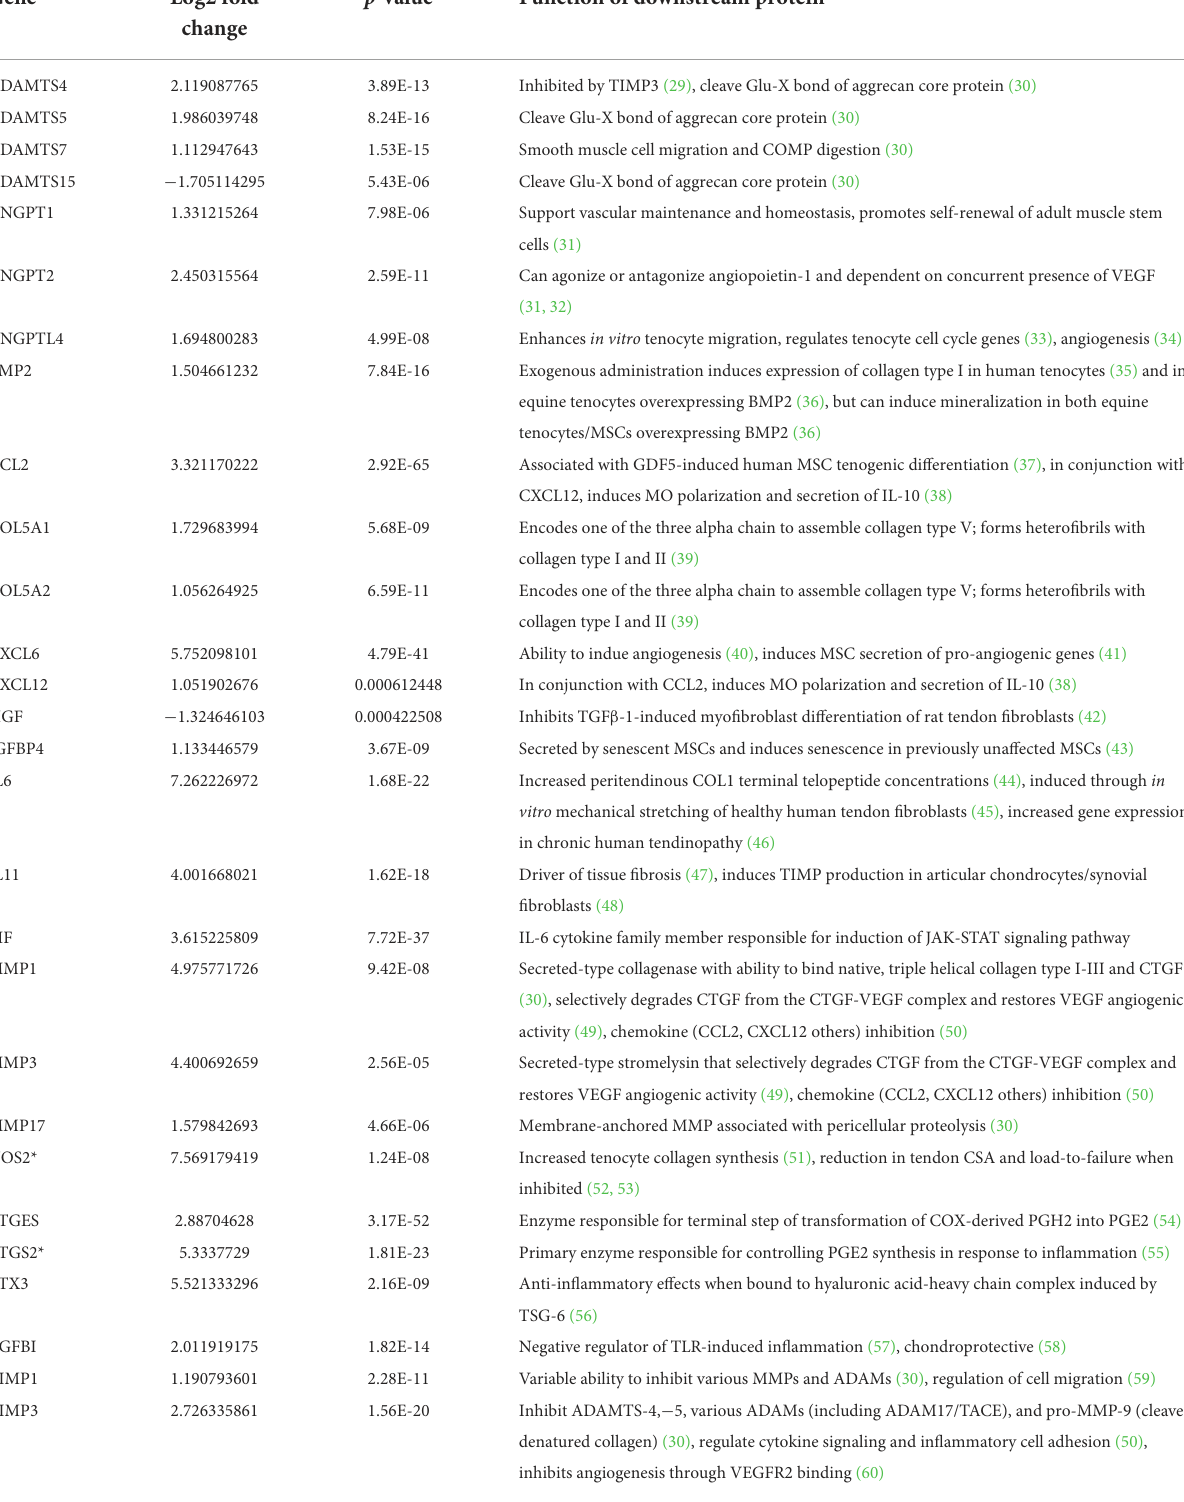
TABLE 1 Function of downstream proteins produced from DEGs identified from IL-1 β licensed MSCs that could impart tendon-relevant effects. p -value Function of downstream Gene Log2 fold change